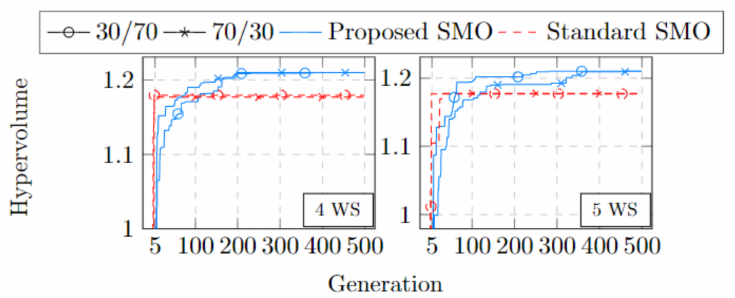
Figure 9. Convergence rate plots of the standard and proposed SMO approaches for the 9 operators scenario distributed in 4 and 5 WSs. Table 4. Quantitative HV comparison for the 9 operators scenario distributed in 4 and 5 WSs. WS